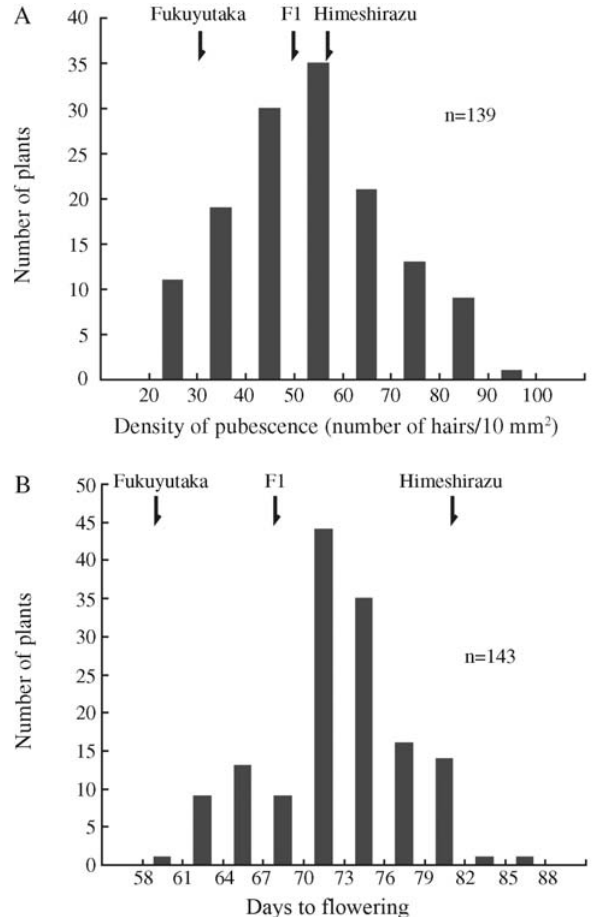
Figure 1 - Distribution of pubescence density and days to flowering in the F 2 segregating population derived from a cross between the Fukuyutaka and Himeshirazu cultivars. (A) The number of hairs in 10 mm 2 of leaf un- derside. Four plants were excluded from analysis because they did not